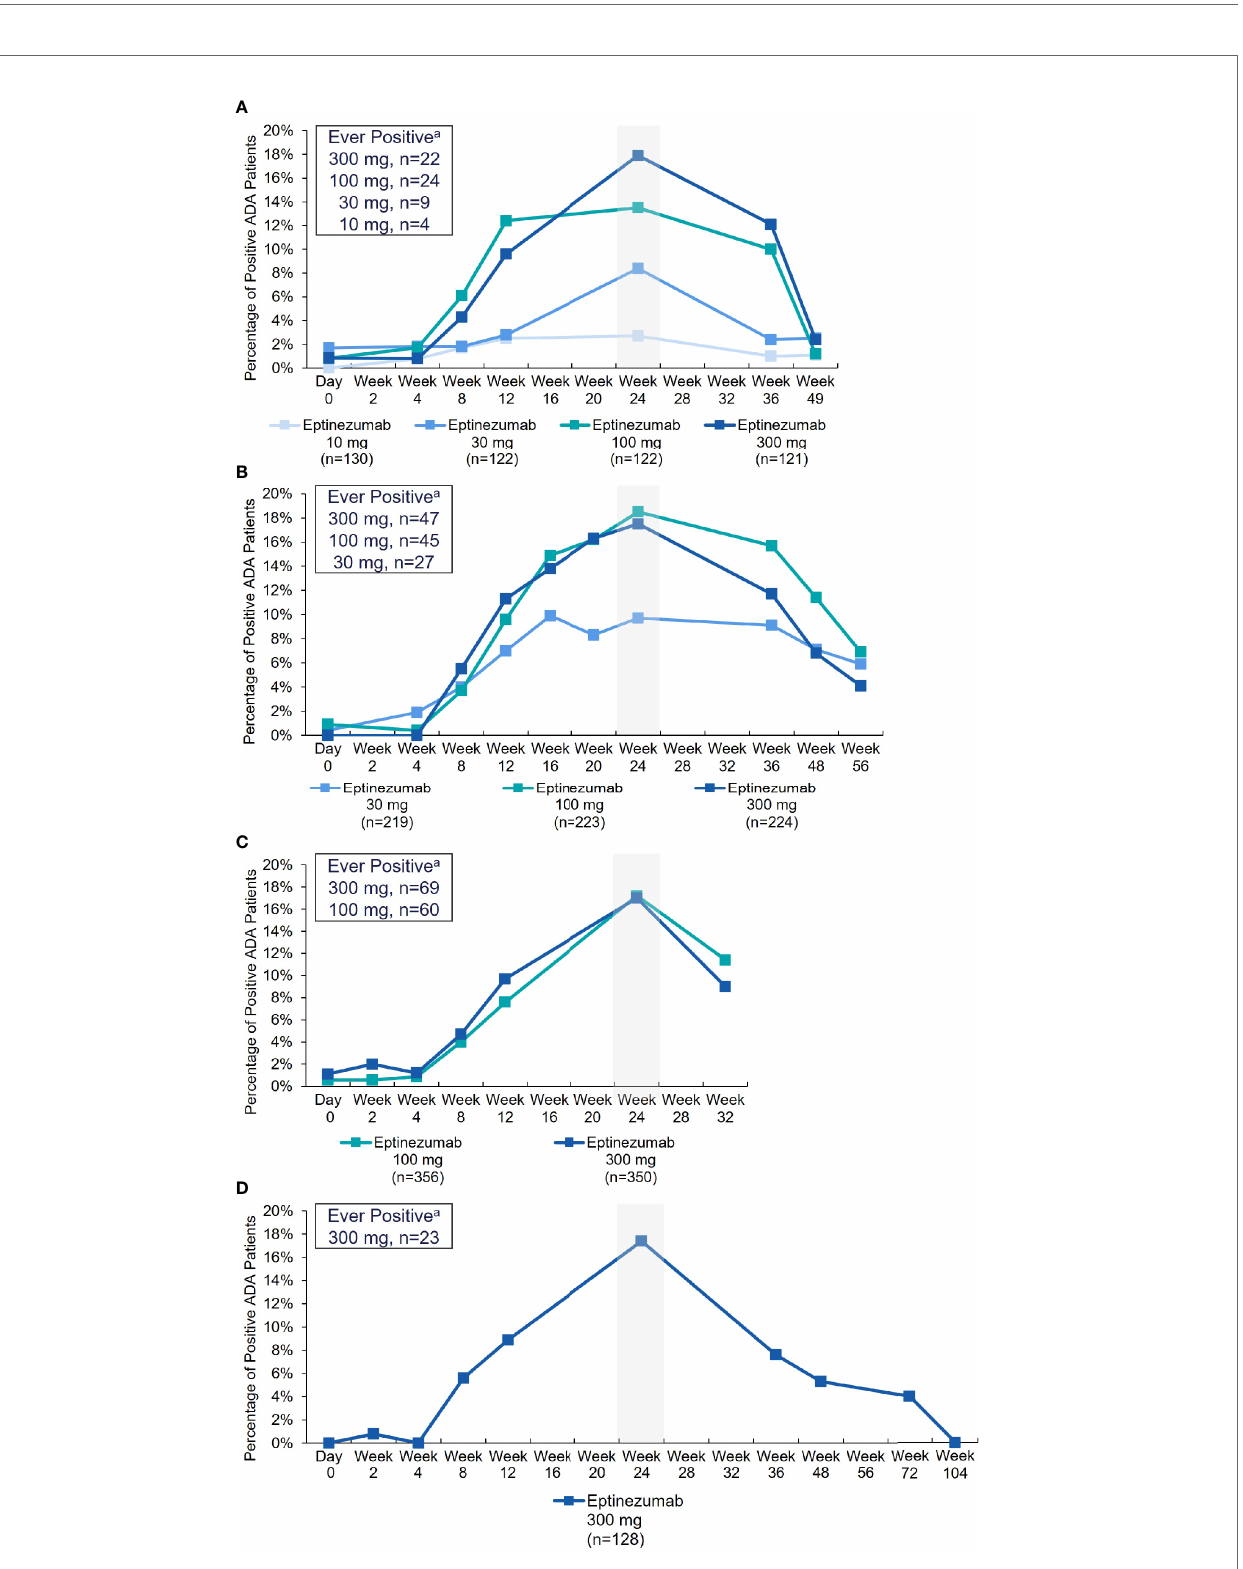
FIGURE 1 | Percentage of ADA-positive patients by visit and treatment (safety population) in: (A) Study 2, (B) PROMISE-1, (C) PROMISE-2, and (D) PREVAIL. a Represents number of patients ever ADA positive over the entire time course analyzed for each study. Note: The denominator for the percentage is the number of patients with ADA sampling results per treatment group at each visit. ADA, anti-drug